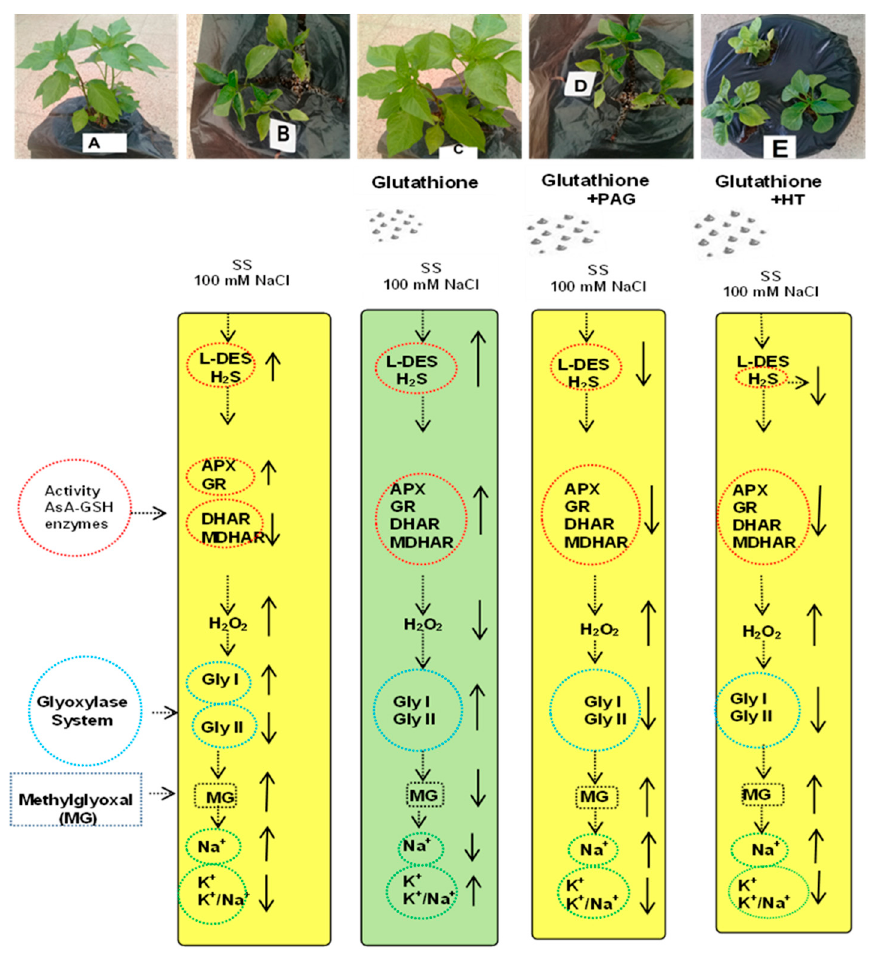
Figure 11. E ff ects of glutathione (GSH) and the inhibitor of l -cysteine desulfhydrase ( l -DES), dl -propargylglycine (PAG), or the scavenger of hydrogen sulfide (H 2 S), hypotaurine (HT), on pepper plants subjected to control ( A ) and salinity stress ( B ), sprayed with glutathione ( C ) combined with inhibitor of l -DES, dl -propargylglycine (PAG; D ) or scavenger of H 2 S, hypotaurine (HT; E ). A proposed model depicting the participation of l -DES and H 2 S in GSH-induced SS tolerance in pepper plants.